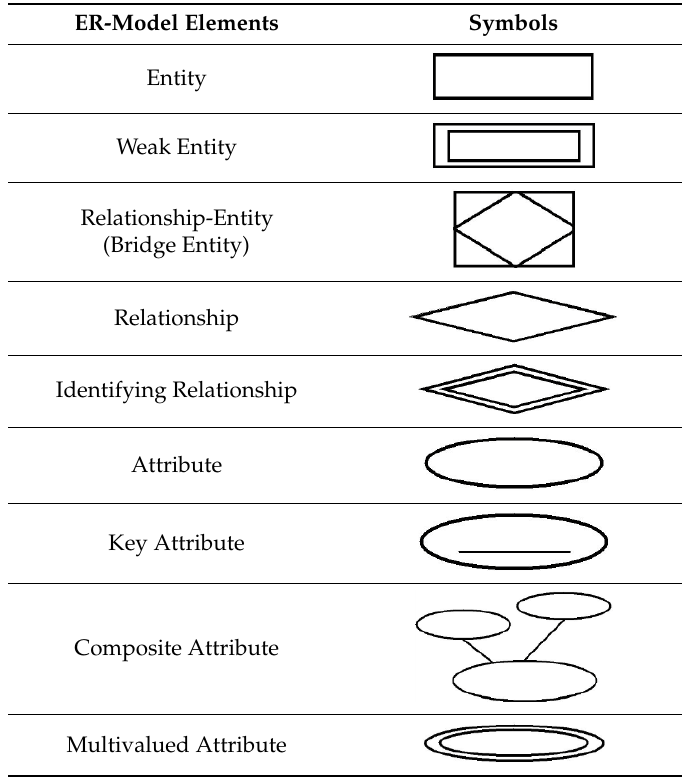
Table 2. The common geometries of the ER-model.